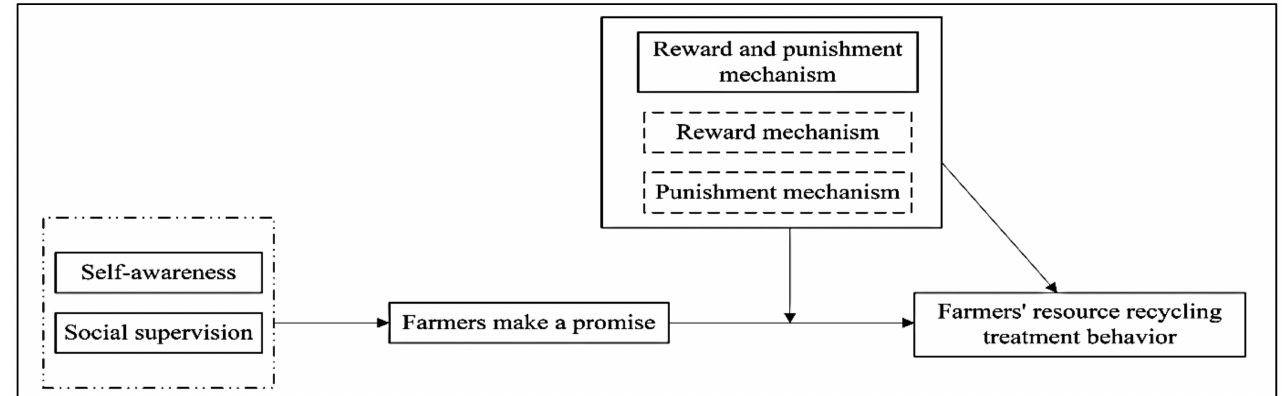
Figure 3. Theoretical framework of the study.